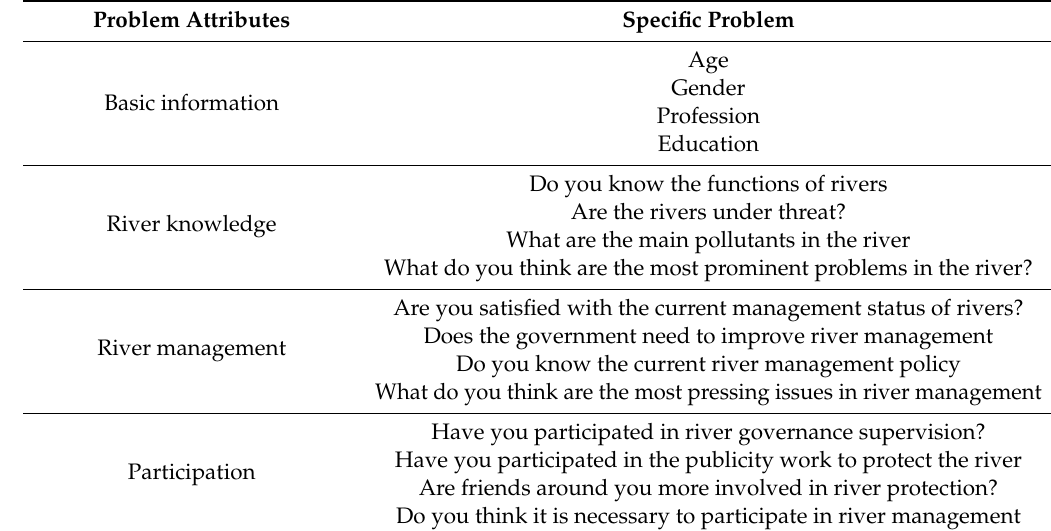
Table 1. Questionnaire of the public’s cognition degree of the river status and river